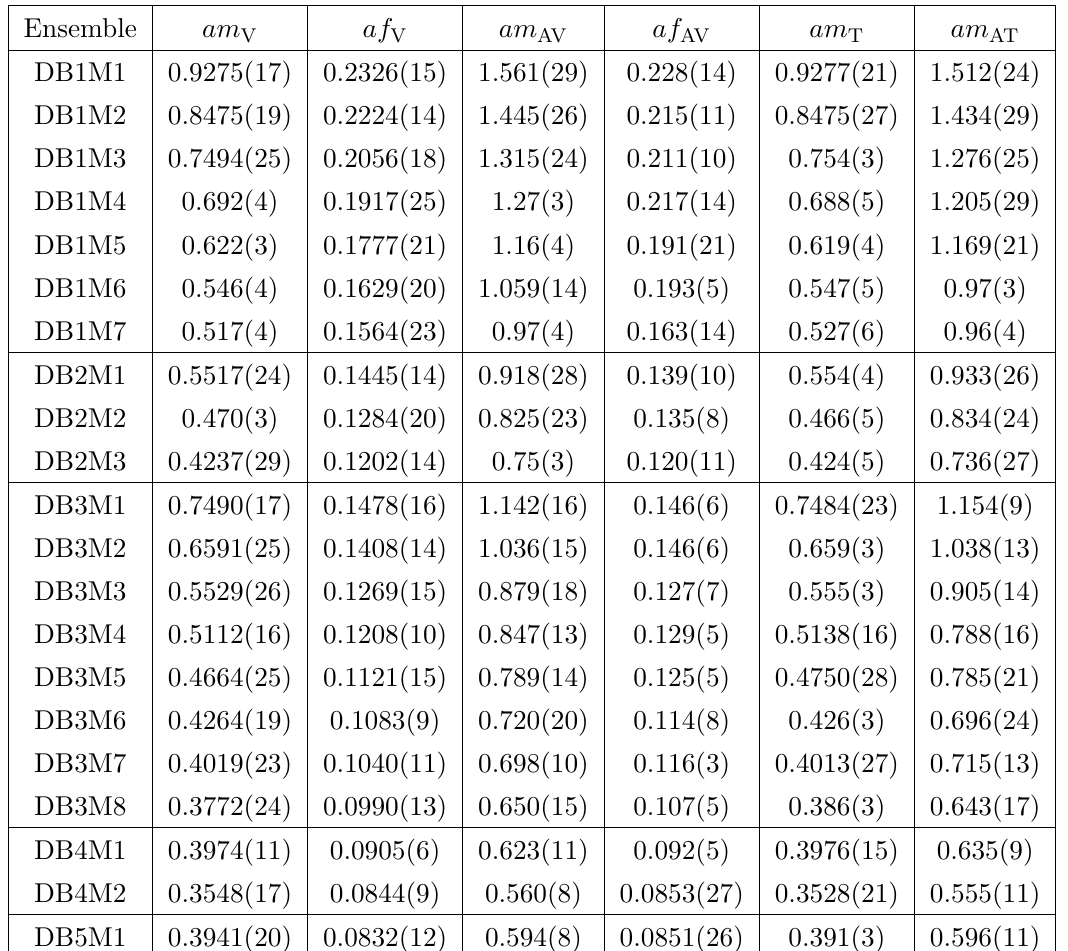
Table 7. Masses and (renormalised) decay constants for (cid:13)avoured mesons sourced by vector (V), axial-vector (AV), and tensor (T) and axial-tensor (AT) operators in lattice units. The V and AV decay constants are renormalised via the one-loop perturbative matching in eq. (4.6). Statistical uncertainties are indicated in